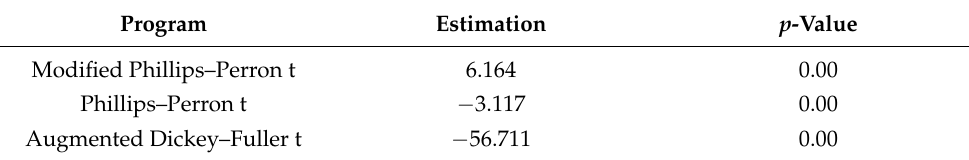
Table 6. Co-integration test